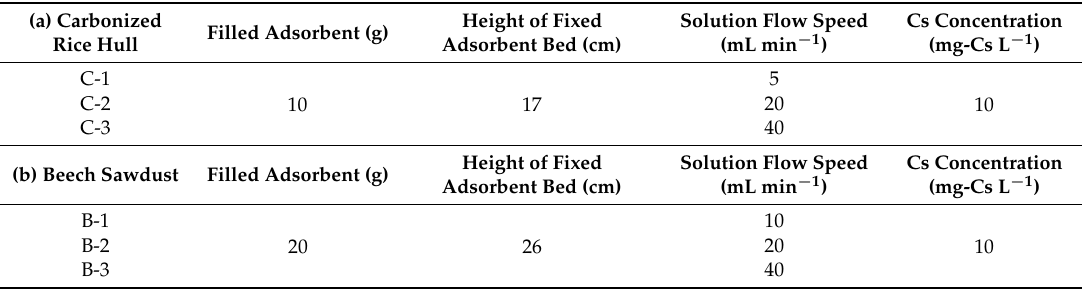
Table 2. Conditions at the breakthrough point and end point in experiment 1; (a) carbonized rice hull and (b) beech